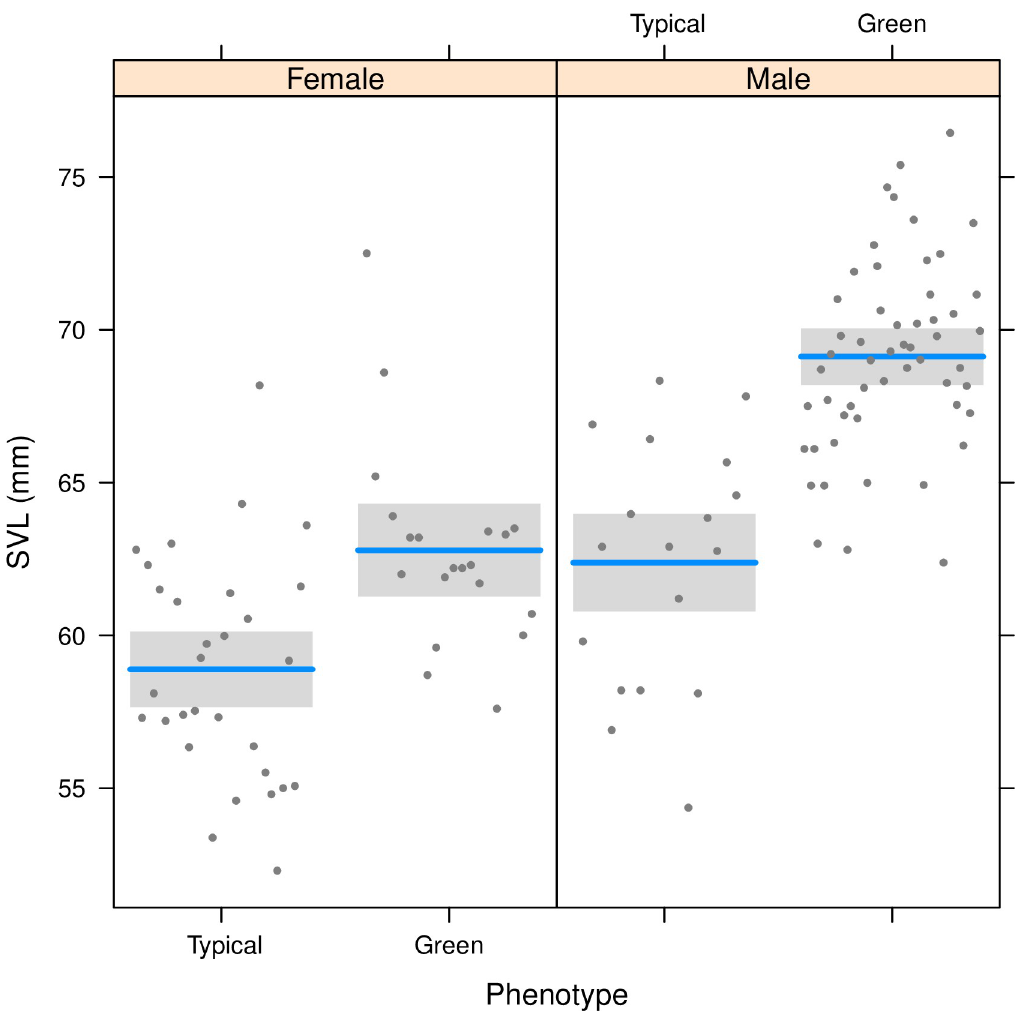
Fig 4. Differences in snout-vent length (SVL) between male and female lizards from Capo Grosso, and differences between individuals with the typical phenotype and individuals with the green phenotype. Shaded areas indicate 95% confidence intervals; dots represent the measured